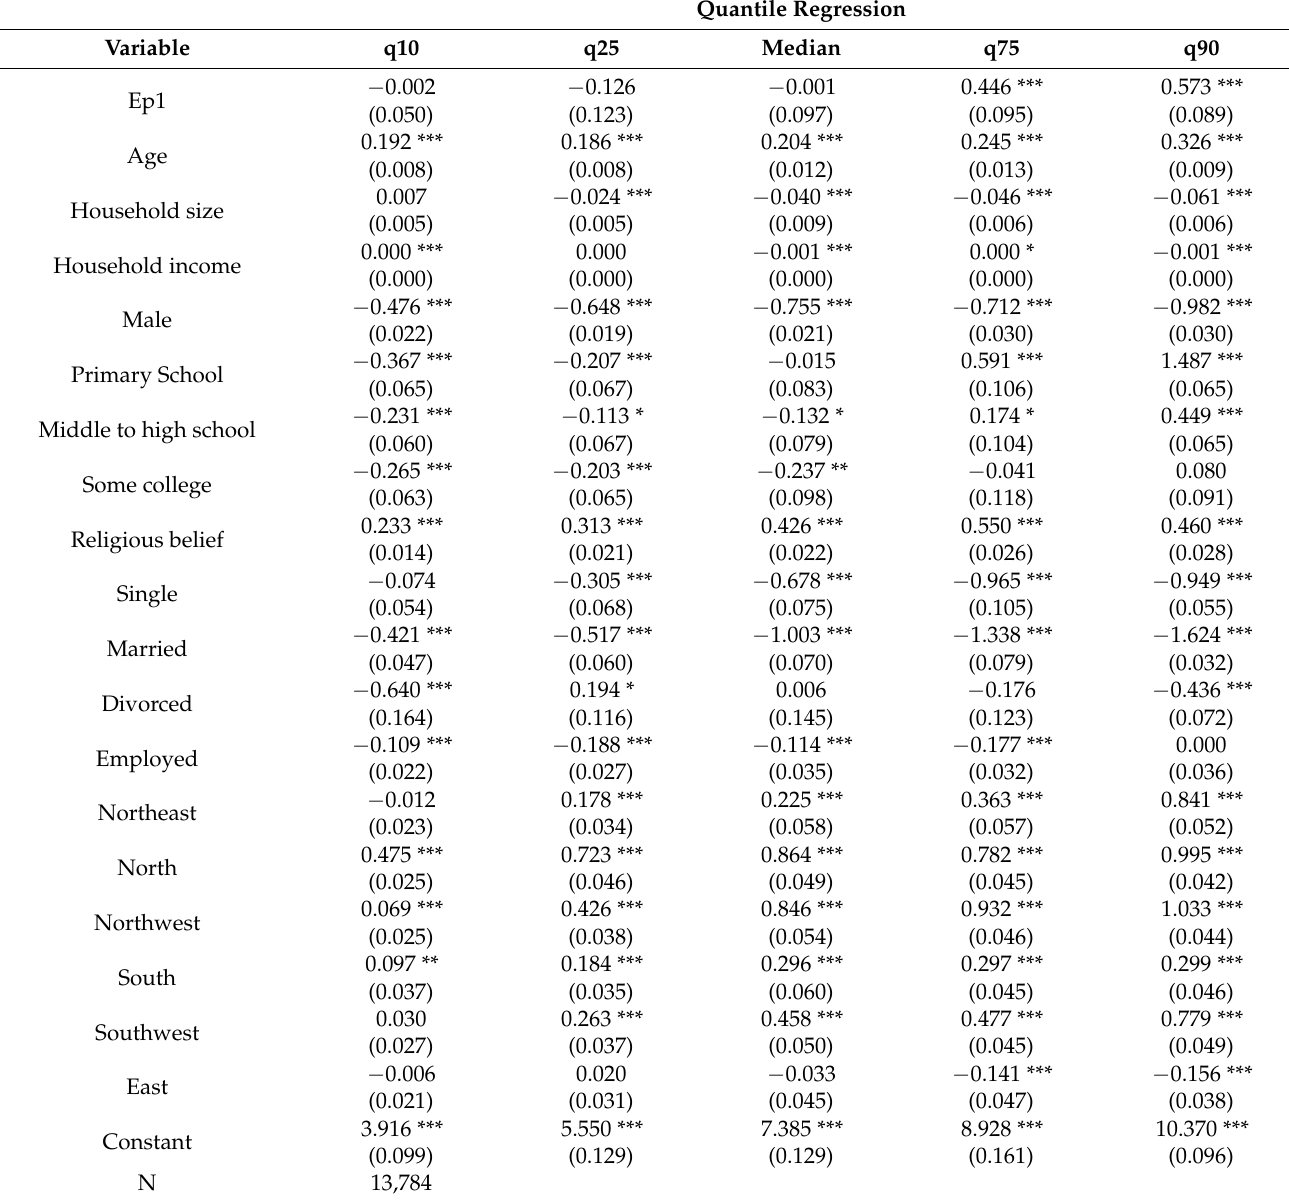
Table 3. Estimated parameter coefficients from the instrumental variable quantile regression model with EP1 as energy poverty measure. Quantile